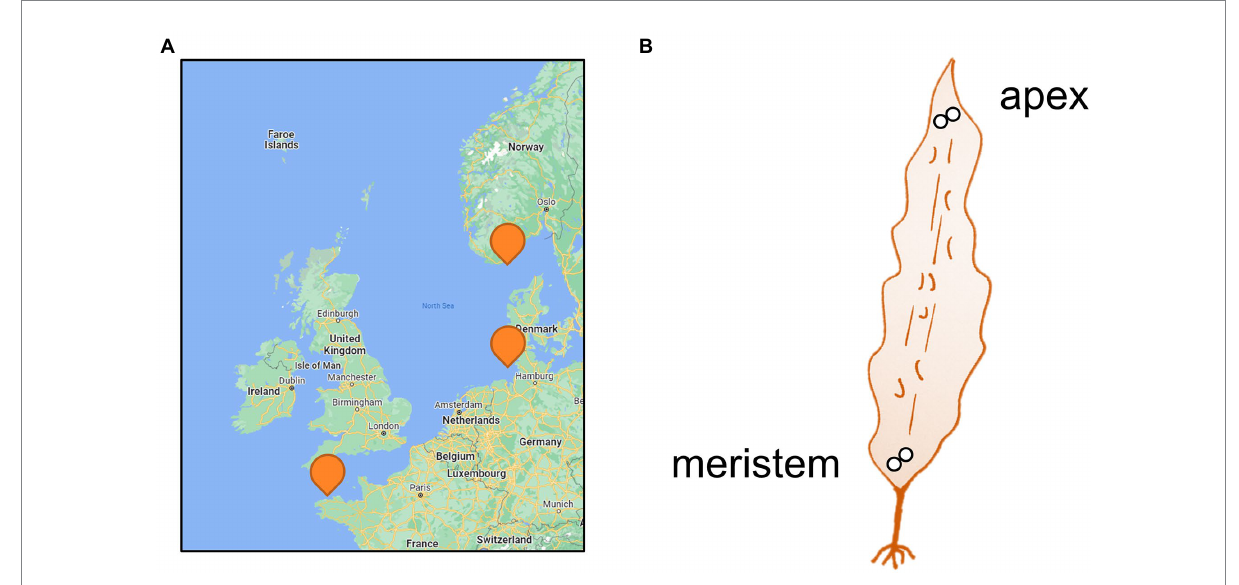
FIGURE 1 Sampling. (A) Map of sampling locations and (B) Sampled parts of the Saccharina latissima thalli (<1 m). Two discs (Ø2cm) were punched out in immediate proximity for each part of the blade and preserved in silica gel. Please refer to Table 1 for details on the sampling